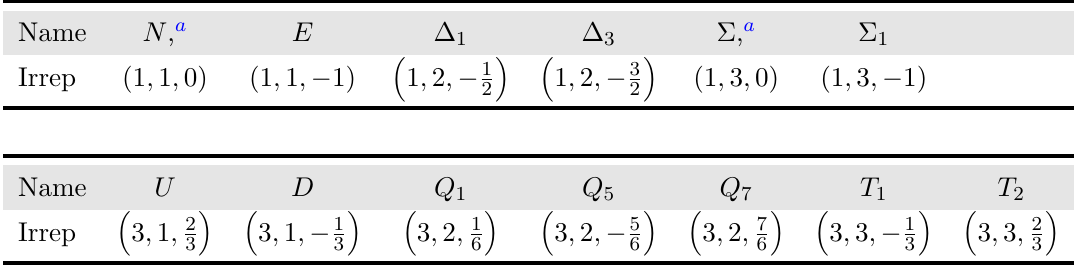
Table 2 . Fermion exits: new vector-like fermions that can couple to standard model fields. Lagrangian. That term will allow to generate a d = 6 operator in SMEFT at tree-level and, at the same time, is responsible for the decay of the BSM field. In the table we give the quantum numbers of the scalars in the order SU(3) symbols proposed in